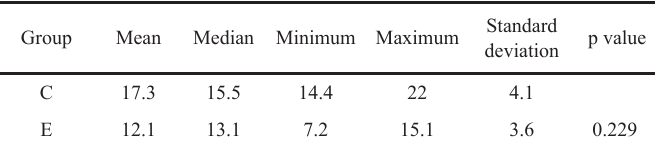
FIGURE 1 – Photomicrography abdominal wall and spleen control group, 49 days (HE-200x).